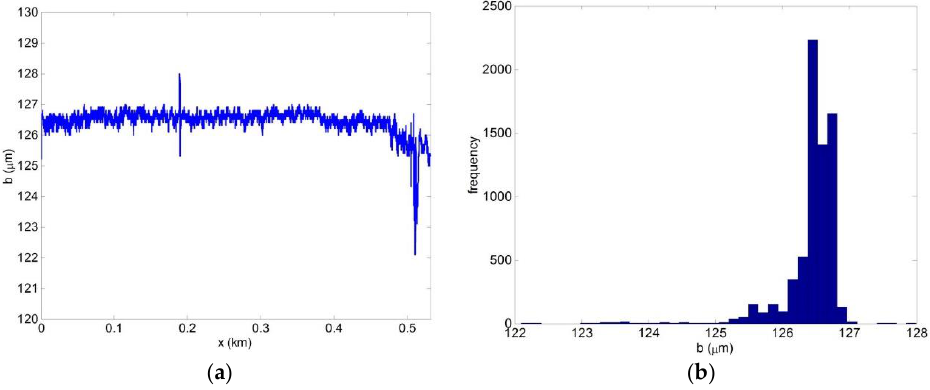
Figure 6. LOMF 100/125 end (CCDR measurement): ( a ) beginning of the drawn length; ( b ) end point.